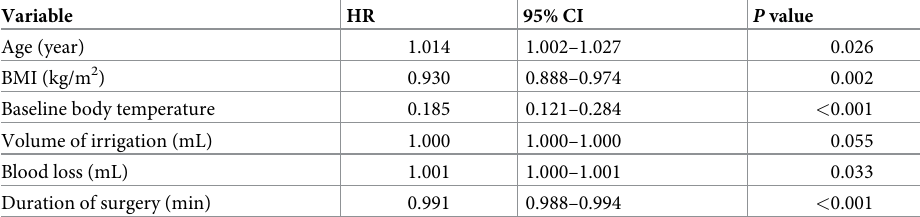
Table 3. Risk factors for inadvertent hypothermia on multivariable Cox regression